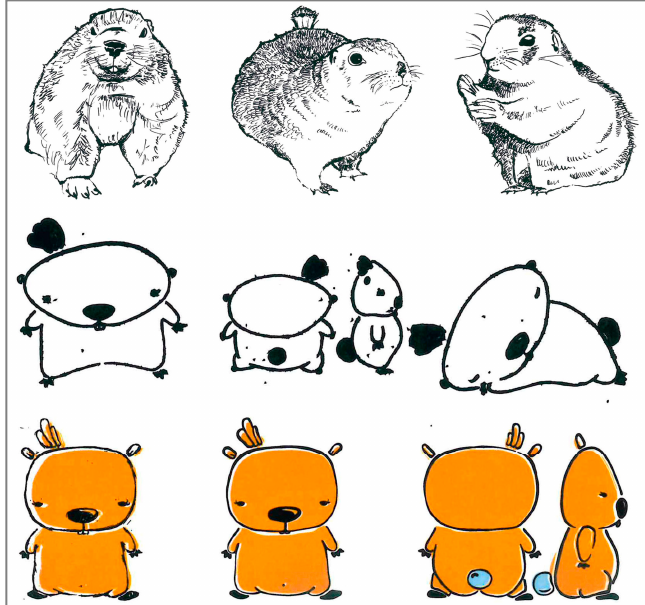
Figure 2. The choosing of the protagonist: from the left, to the right, a prairie dog, a crib and a marmot. Below, the progressive drawing of the marmot: the simplification is useful to facilitate children affected by visual impairments in the recognition of the different parts. Drawings made by E. Reinaudo